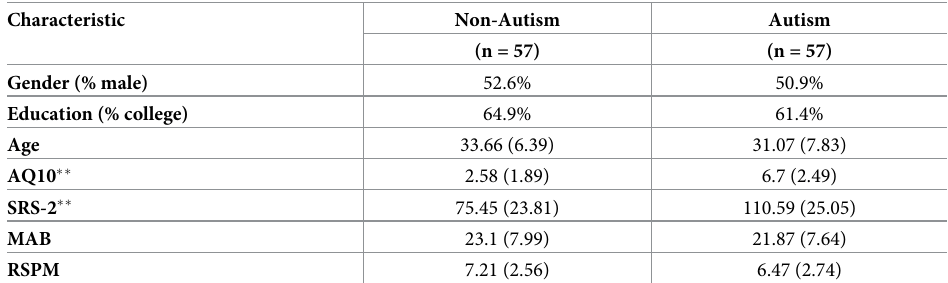
Table 2. Participants’ characteristics in the two study groups. Standard deviations appear in parentheses.